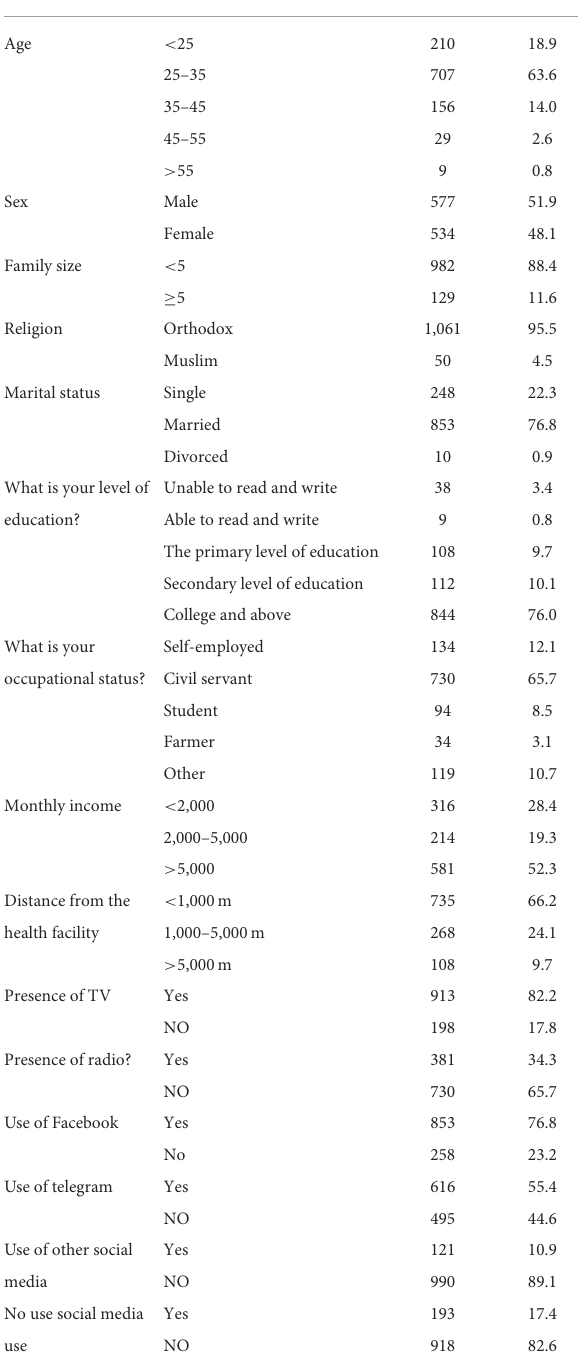
TABLE 1 Socioeconomic and sociodemographic characteristics of study participants.